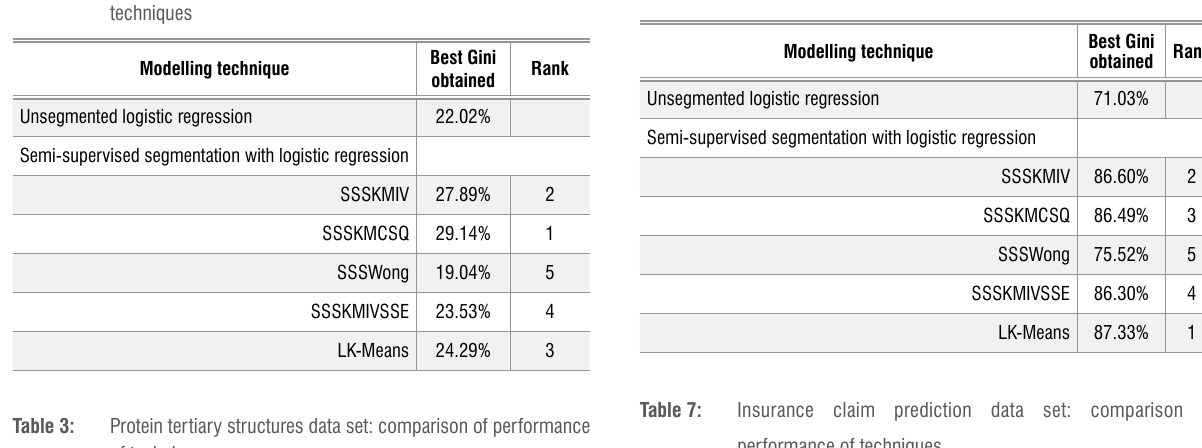
Chess king-rook vs. king data set: comparison of performance techniques